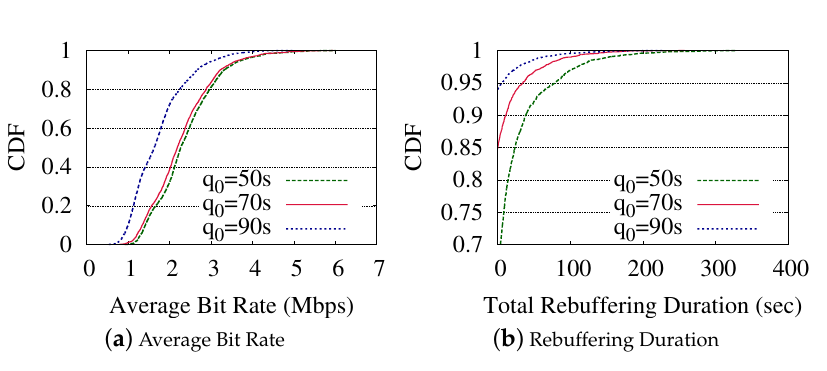
Figure 5. Effect of q 0